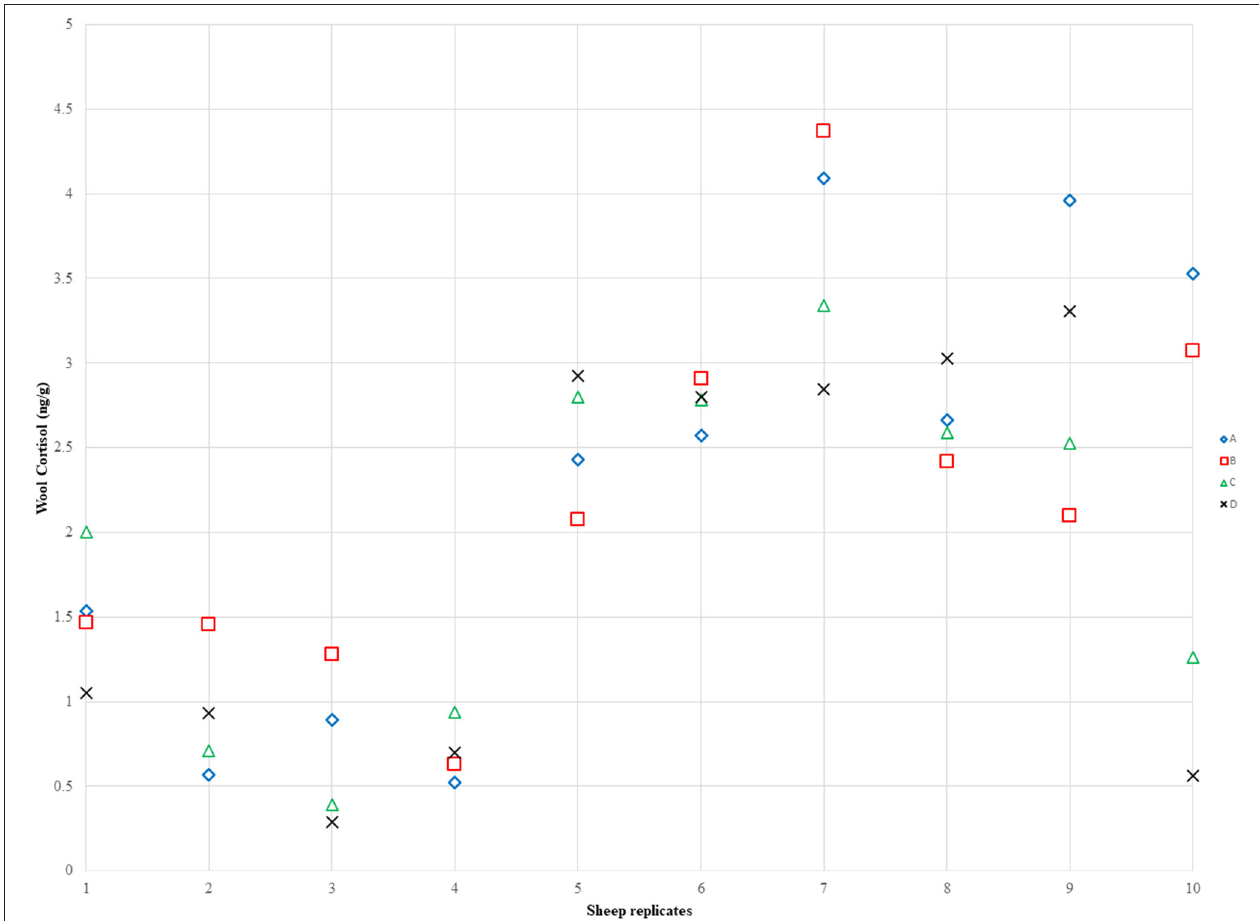
FIGURE 3 | Visual representation of the intra-variance cortisol concentration between the subsamples for every sample. Each number on the x-axis represents a wool sample and the sub-samples from that sample are on the same y-axis line based on the different cortisol concentration detected on each sub-sample. There is no significant difference between subsamples but there is between samples from different